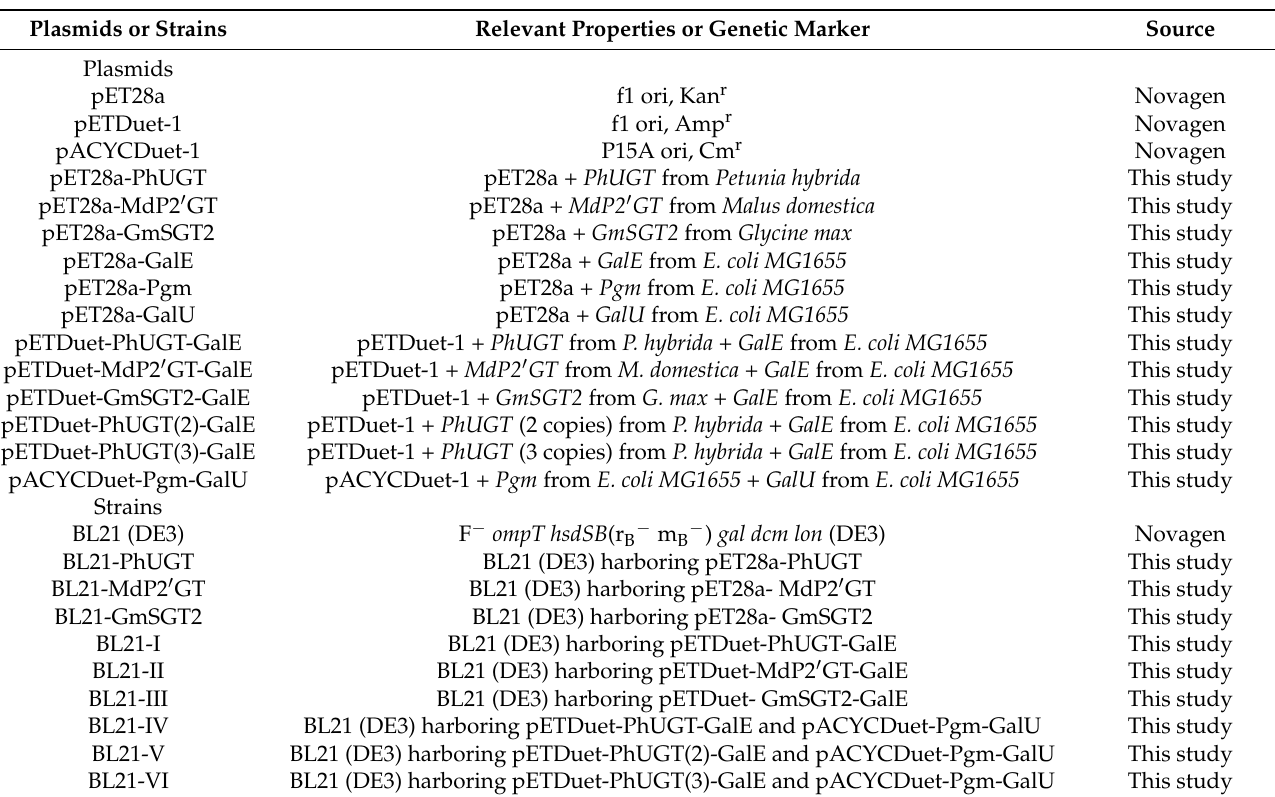
Table 1. Plasmids and strains used in the present